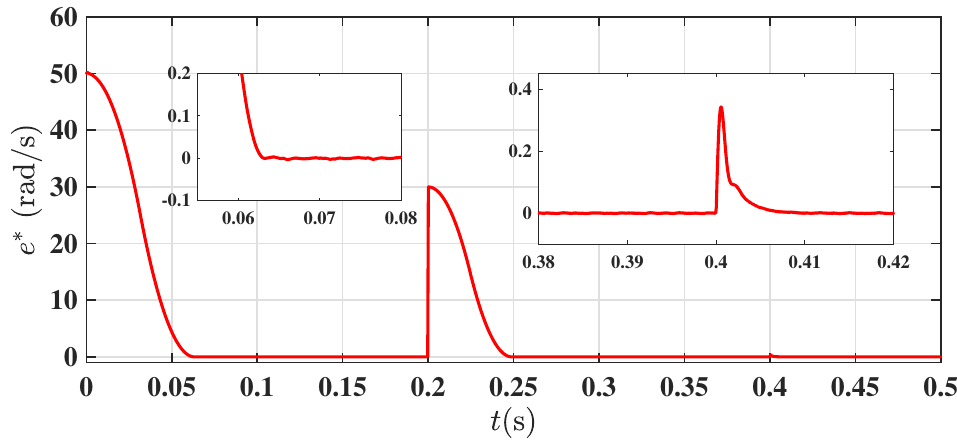
Figure 8. The evolution curve of the error e